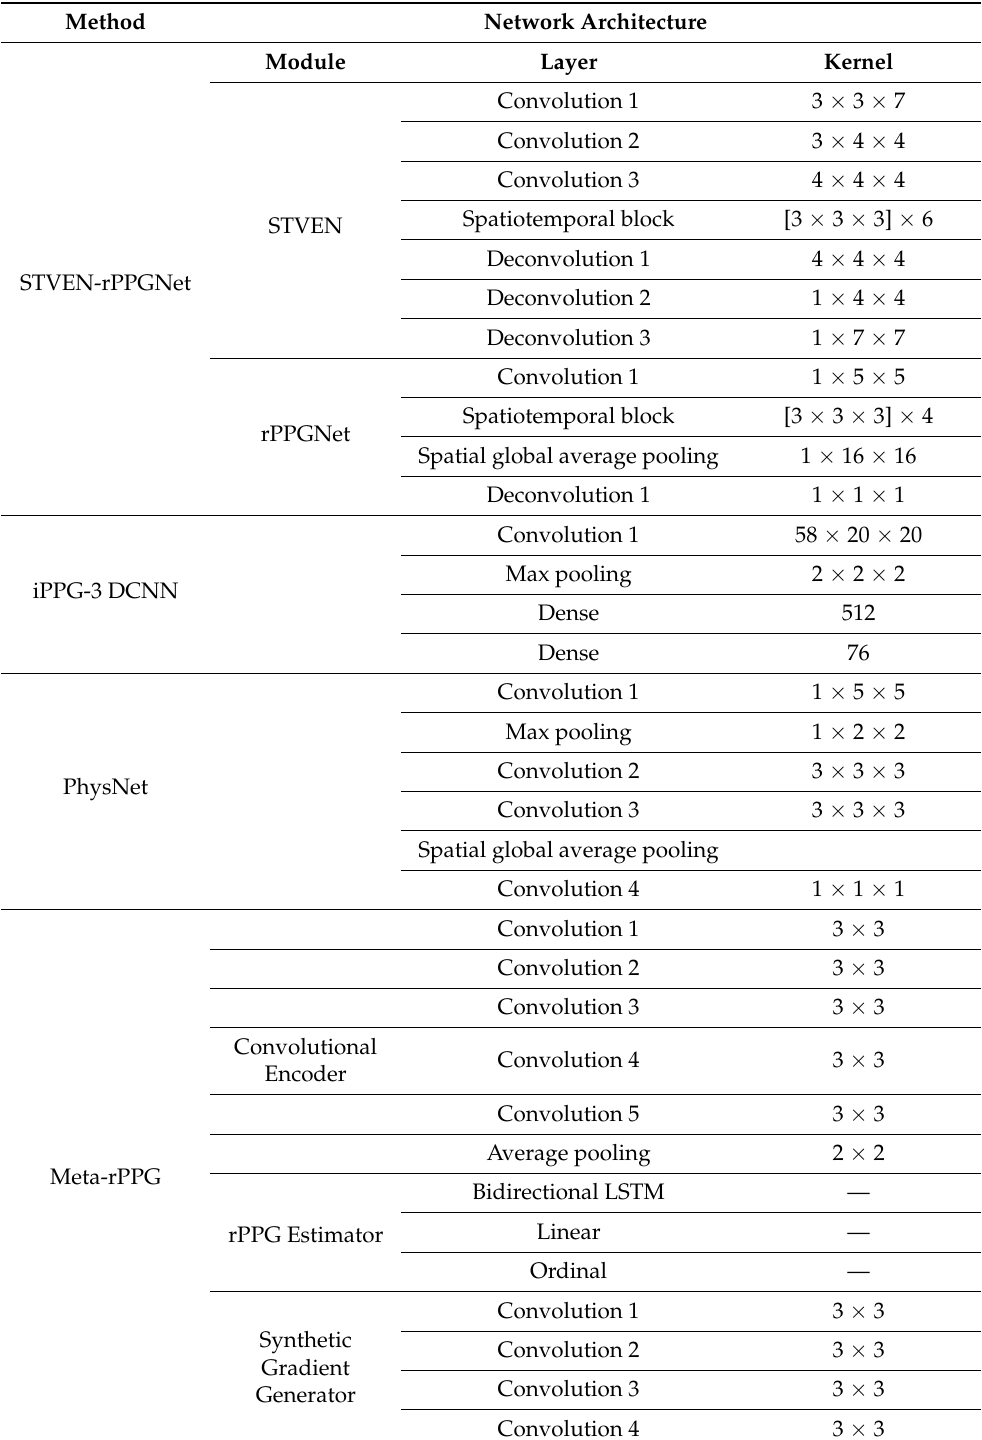
Table 4. Overview of the selected network